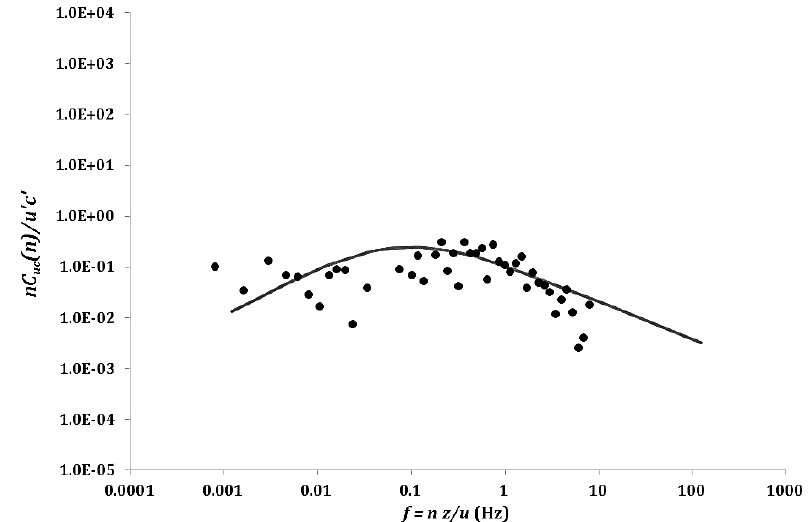
Fig. 3. Normalized logarithmic cospectra for CO 2 flux as a function of the normalized frequency ( f ), where n is the natural frequency, u is the wind speed and z the measurement height. The dots show the measured spectra and the solid line shows the calculated spectra for neutral conditions using the equation from Kaimal et al.